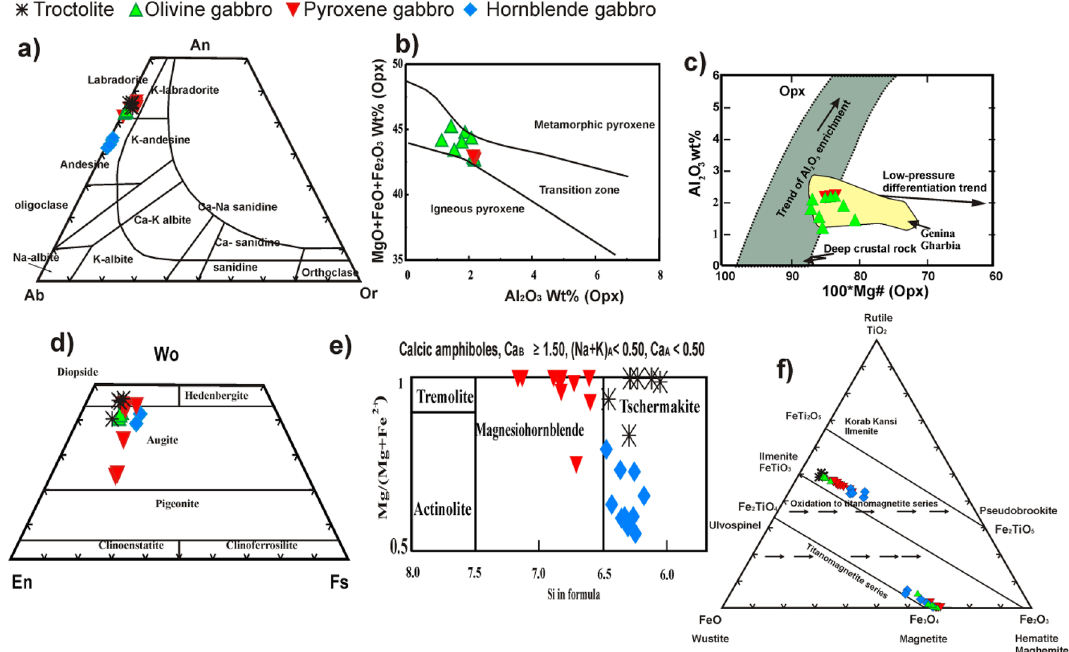
( b ) Classification of orthopyroxene 20 , ( c ) Variation diagram of Al 2 O 3 (wt%) vs. 100*Mg# of Opxs. Fields of deep crustal rocks 21 and Genina Gharbia Alaskan rocks 21 are used for comparison, ( d ) Wo-En-Fs nomenclature diagram of Cpx 23 , and ( e ) Amphiboles nomenclature diagrams of 24 , and ( f ) TiO 2 –FeO–Fe 2 O 3 classification diagram 16